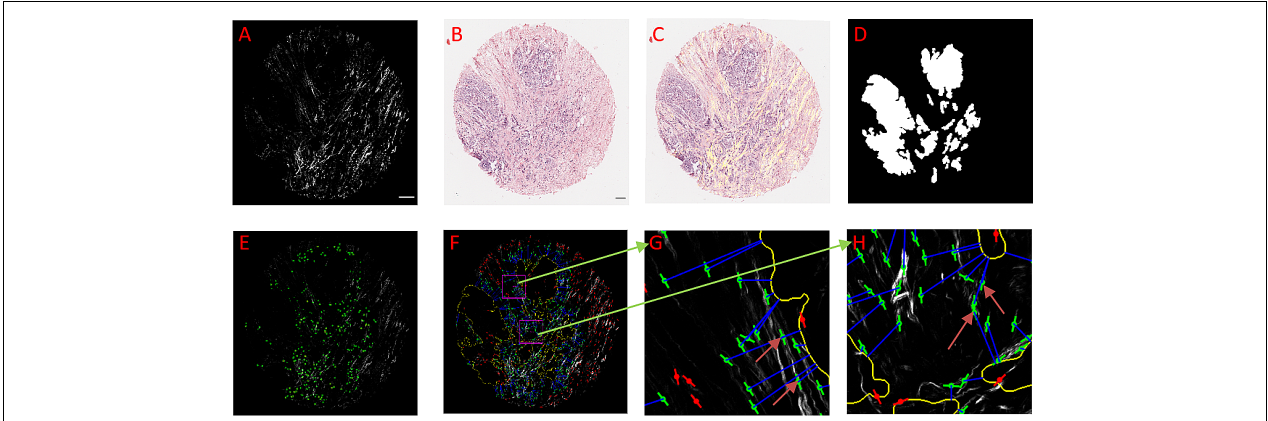
FIGURE 3 | An example of using CurveAlign to create tumor boundary from a bright-field image and quantify the relative angle on a breast cancer TMA core. (A) The SHG image, (B) Original bright-field image, (C) SHG image (in yellow) overlaid on top of the registered bright-field image. (D) Segmentation generated boundary mask. (E) Heatmap of the relative angle with red color shows the region where one or more fibers have an angle larger than 60 ◦ . (F) CurveAlign overlay image with the lines indicating the fiber center locations and orientations overlaid on the top of the SHG image; the outline of the tumor boundary is highlighted in yellow, and the two rectangular ROIs are in magenta; a blue line is used to associate the center of fiber with the corresponding boundary locations, and the red lines indicate the fibers located either beyond the distance range or inside the boundary, and green lines are the fibers of interest. (G) and (H) Zoomed-in ROI results. The arrows in these images show that the fibers either more parallelly aligned in (G) with respect to the boundary or are more perpendicularly aligned in (H) with respect to the tumor boundary. In boundary creation, pixel per micron ratio was set to 1.65; fiber extraction in CT-FIRE used default settings; the distance parameter was set to 150 pixels; the SHG image size is 2048 by 2048 pixels, and the sizes of ROI are identically set to 256 by 256 pixels. Images (A,C–F) are shown at the same scale while images (G) and (H) are shown at the same scale. Scale bar equals 100